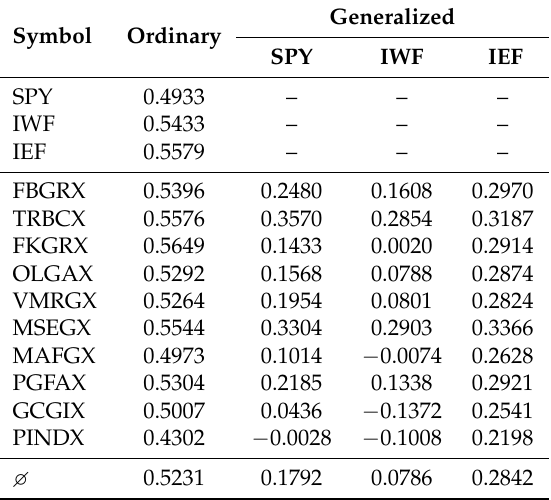
Table 2. Ordinary vs. generalized Sharpe ratios